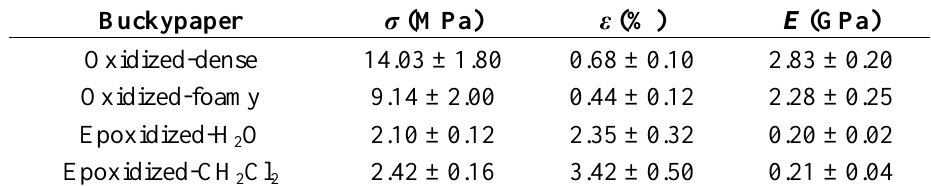
Table 2. Tensile data of the buckypapers: σ is the tensile strength at fracture, ε is the fracture strain and E is the Young